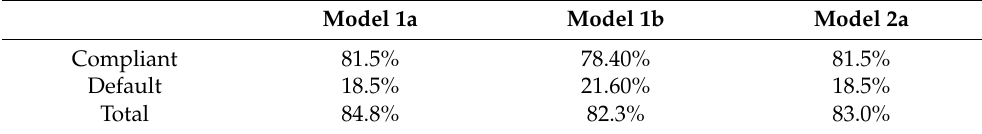
Table 5. Success rate of the proposed